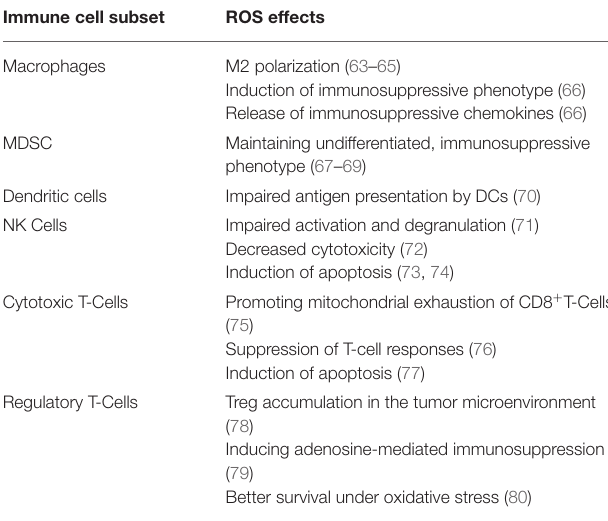
TABLE 1 | Effects of excessive ROS levels on different populations of immune